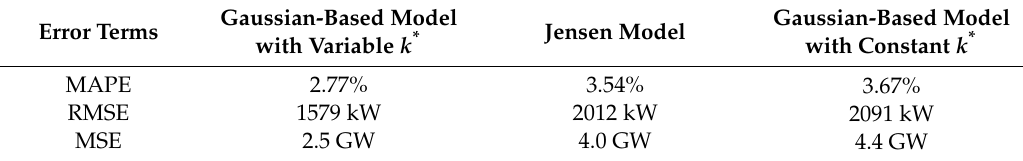
Table 1. Models’ sitewide total power prediction errors in 100 selected cases. Table 1. Models' sitewide total power prediction errors in 100 selected cases.